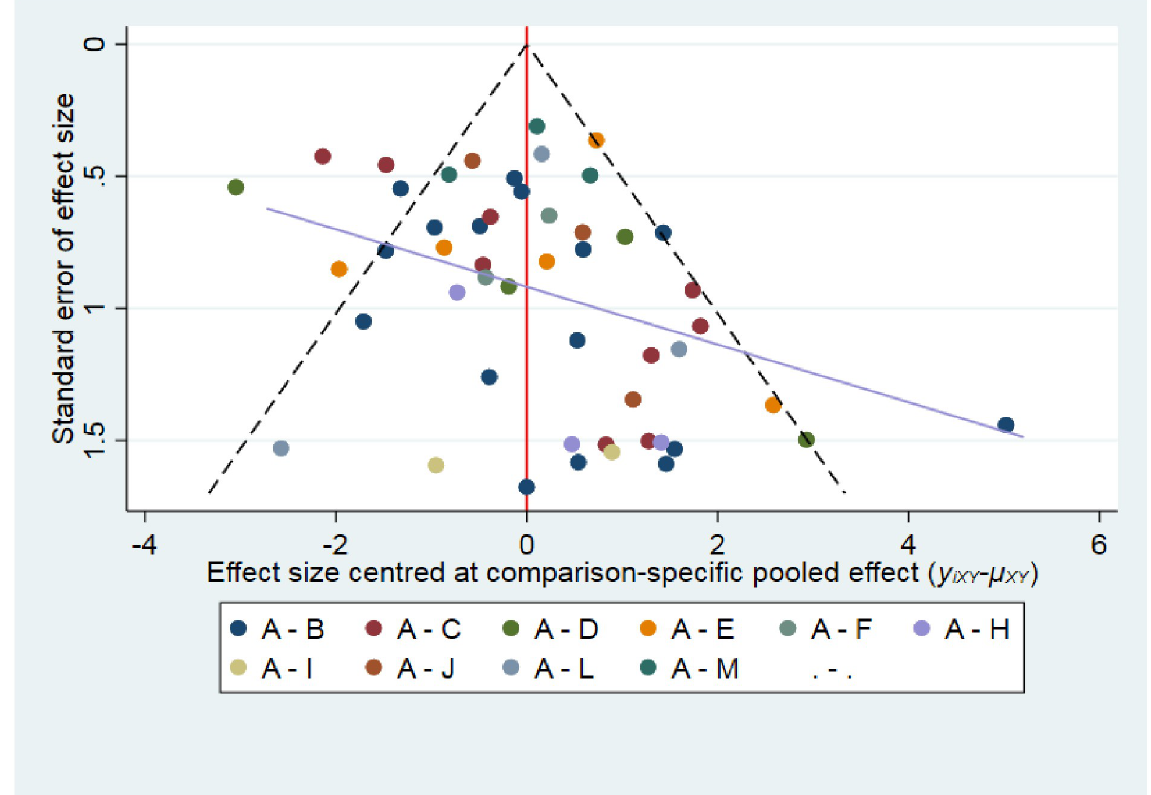
Fig 4. Comparison-adjusted funnel plot for the selected studies with the incidence of moderate-severe oral mucositis. Abbreviation: A, placebo; B, glutamine; C, honey; D, povidone-iodine; E, chlorhexidine; F, aloe; G, benzydamine; H, Curcumin; I, allopurinol; J, granulocyte- macrophage colony-stimulating factor; K, lignocaine; L, sucralfate; M, probiotics. Note: Comparisons including only one study (when present) have been